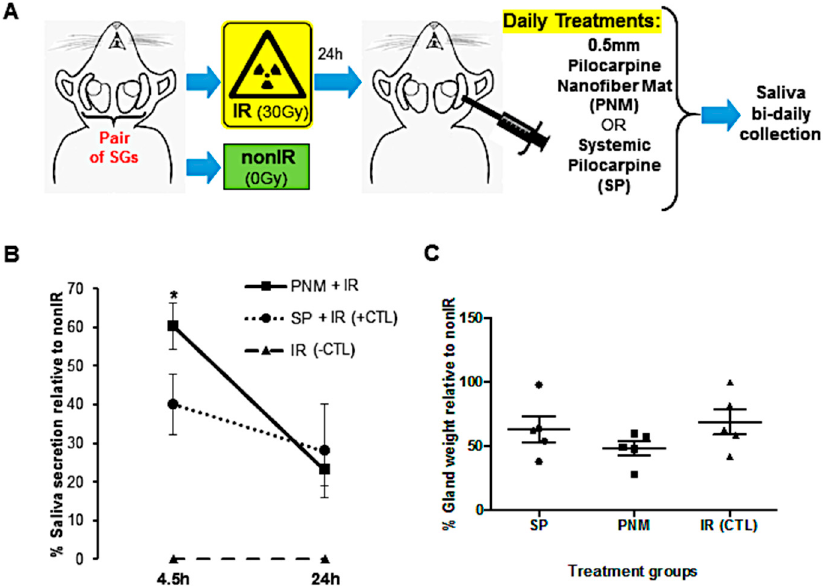
Figure 6. Treatment outcomes during daily intradermal applications of 0.5 mm pilocarpine nanofiber mats versus systemic pilocarpine in an acute in vivo SG model of SG hypofunction. ( A ) Schematic drawing of the in vivo SG hypofunction model to induce acute dry mouth for the daily proposed intradermal treatment with pilocarpine nanofiber mat and conventional systemic administration. ( B ) Saliva secretion rate during the first 24 h after daily intradermal application of 0.5 mm-diameter pilocarpine nanofiber mats (PNM) when compared to systemic pilocarpine (SP). ( C ) Salivary gland weight remained unchanged after intradermal application of 0.5 mm pilocarpine nanofiber mats. Error bars represent SEM from n = 4–5. * p < 0.05 when compared to irradiated group with systemic pilocarpine only (SP, which represents the positive CTL). IR: irradiated (negative CTL). nonIR: non-irradiated control group. SGs: salivary glands.